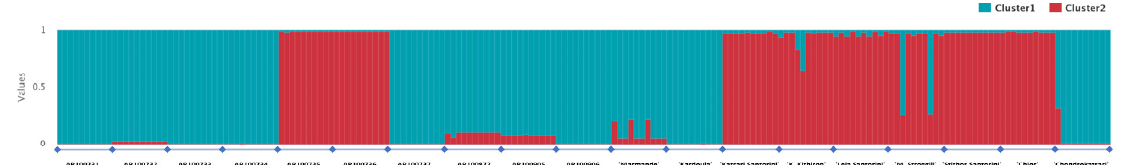
Figure 4. ( A ) Minimum spanning network (MSN) and affiliations of multi-locus genotypes (MLGs) as constructed based on dissimilarity genetic distances. Linear and reticulated connections are evident across genotypes ( B ). Discriminant analysis of principal components (DAPC) among Cypriot landraces and Greek heirloom tomato varieties.